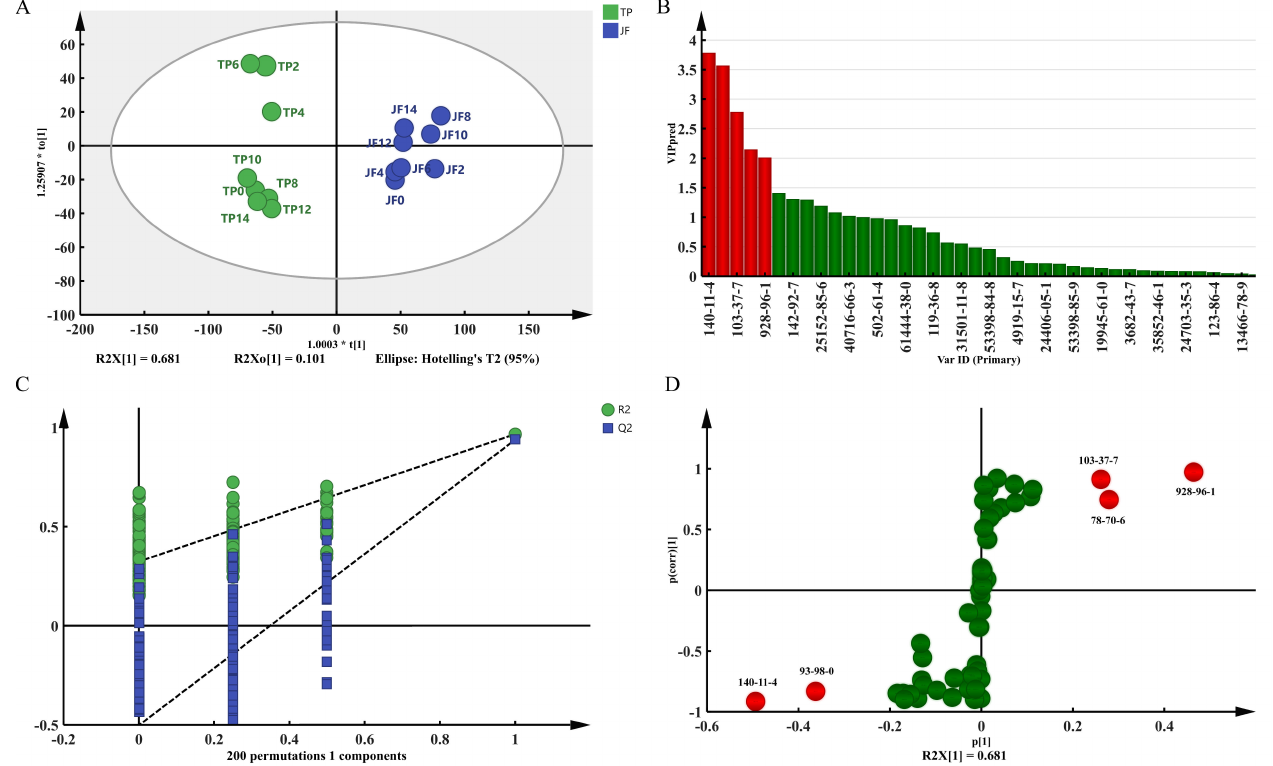
Figure 5. Comparative analysis of volatile components of JF and TP. ( A ) OPLS-DA score plot. ( B ) VIP plot. ( C ) permutation tests plot. ( D ) S-plot. The color in ( B ) and ( D ) means that differential volatile component is marker in green color; those significant differential volatile components with a VIP > 1 and FC > 1.5 or <0.67 ( p < 0.05) marker in red color. Analysis of the Volatile Components between JF and